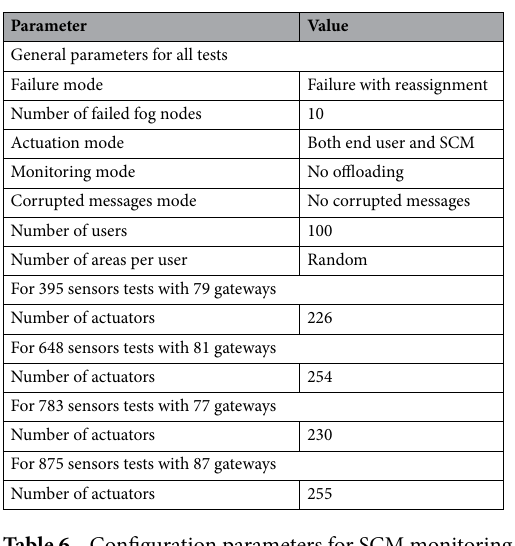
Table 6. Configuration parameters for SCM monitoring offloading modes.